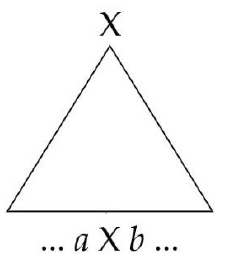
Figure 2. Auxiliary tree.